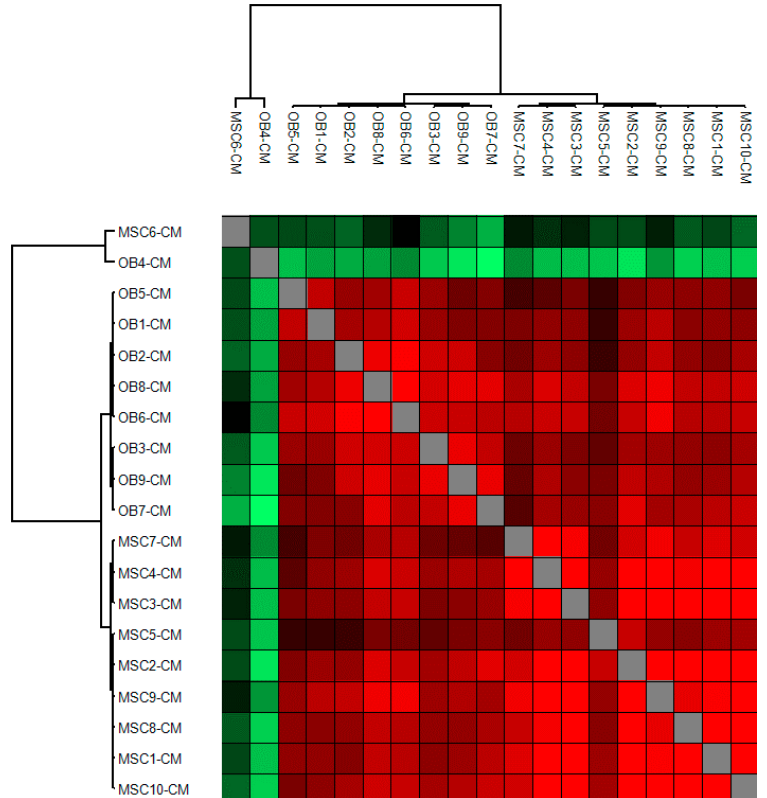
Figure 2. The constitutive protein release by normal MSCs and osteoblasts; hierarchical clustering of Pearson correlation values for the 10 MSC and the nine osteoblast donors. The cluster was generated using Pearson correlation as distance measure and complete linkage of the protein matrix with ≥ 4 valid values for at least one cell type (i.e., either MSCs or osteoblasts). We identified two main clusters corresponding to the two cell types and in addition two outliers (MSC6 and OB4).